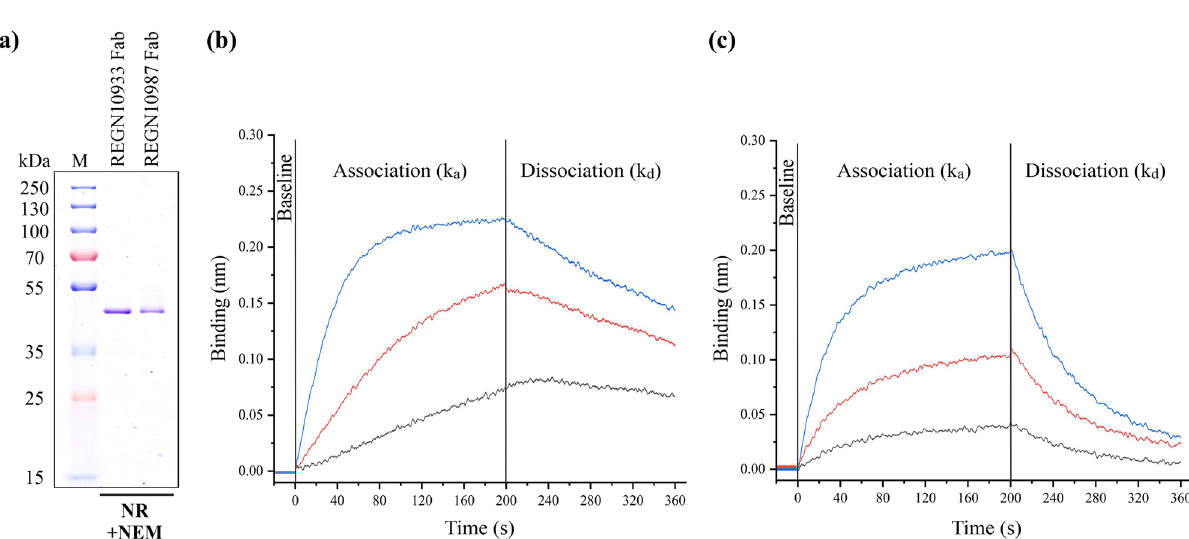
Figure 3. ( a ) SDS-PAGE gel image of purified REGN10933 and REGN10987 antibody fragments under non- reducing (NR), NEM treated conditions; (M: Protein Marker). The proteins of interest were purified using a combination of IMAC and size-exclusion chromatography. See Supplementary Fig. S3 for the uncropped gel image. ( b , c ) Biolayer Interferometry (BLI) based analysis of REGN10933 and REGN10987 Fab binding to wild type SARS-CoV-2 RBD respectively. The interaction curves show an increase in Fab-antigen association with increasing concentration of the Fabs (Grey: 3 nM, Red: 9 nM, Blue: 27